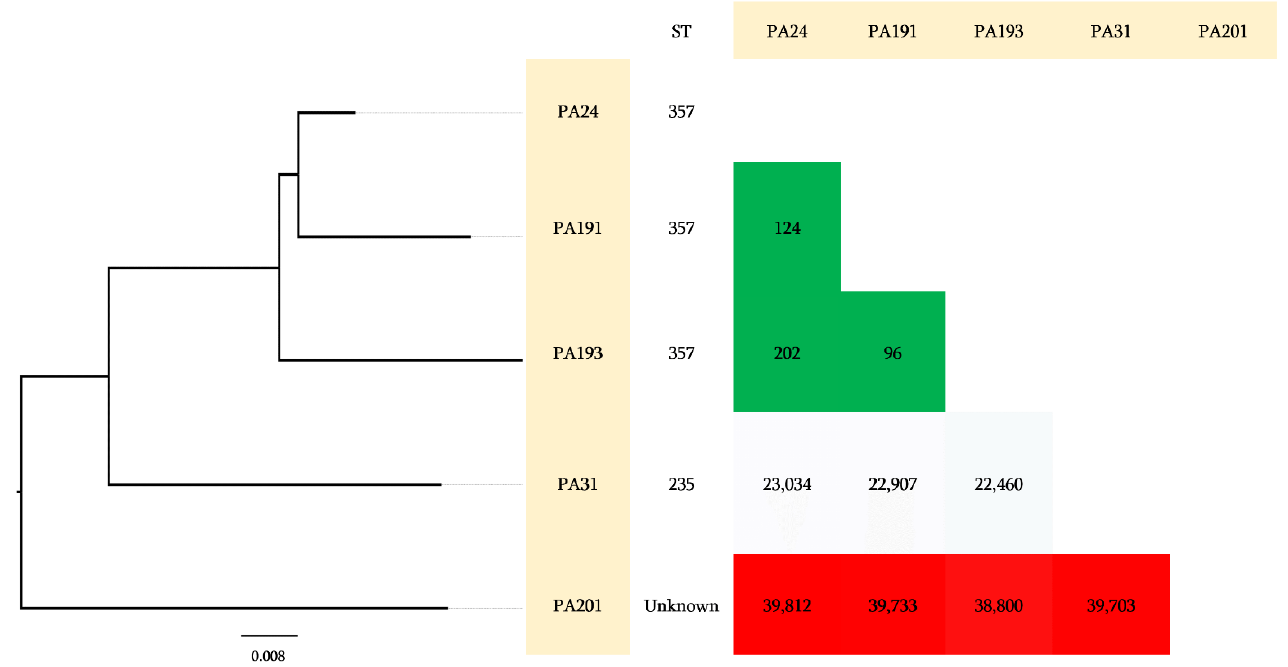
Figure 4. Genomic characterization of P. aeruginosa isolates and the pairwise comparison of the ge- nomic gSNPs. genomic